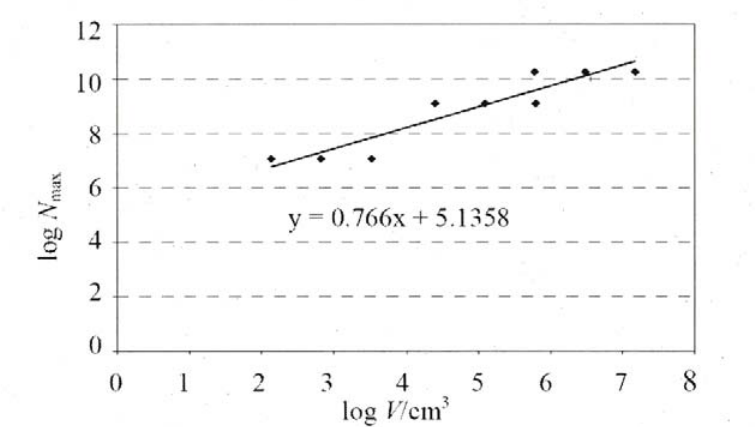
Figure 5: Volume effect on the maximum number of acoustic